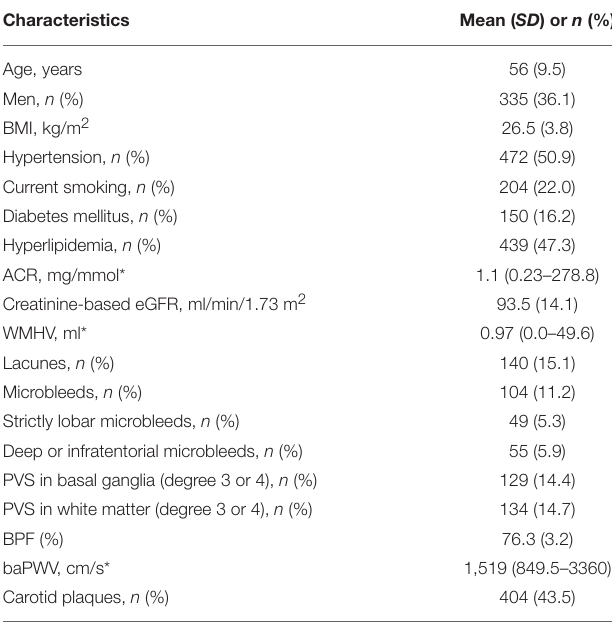
TABLE 1 | Characteristics of the study